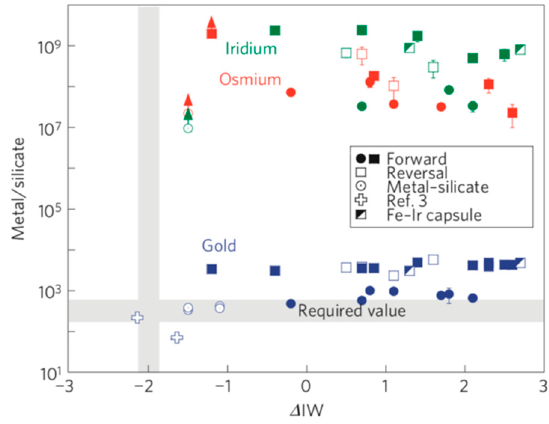
Figure 1. Metal-silicate partition coefficients as functions of the oxygen fugacity. Reprinted with permission from [10].